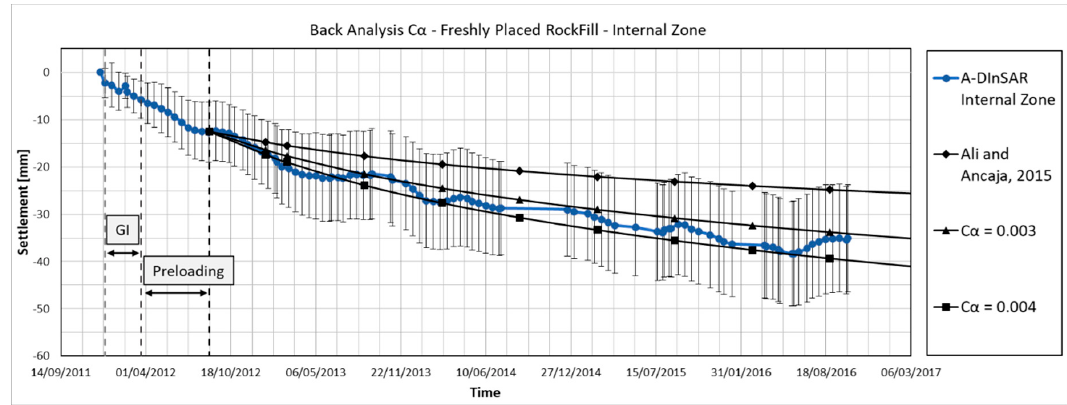
Figure 20 . Results of creep parameter (C α ) after back-analysis for the internal zone of the freshly placed rockfill. placed rockfill.